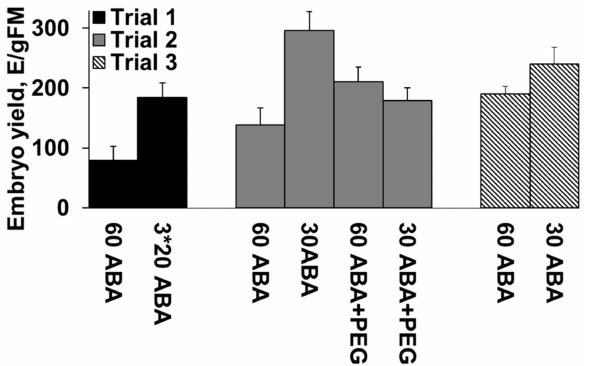
Figure 1. Yield of cotyledonary embryos in different treatments in three Trials in Experiment I. Mean values are presented with standard error bars. In Trial 3, values are presented for genotypes for which maturation with both treatments was